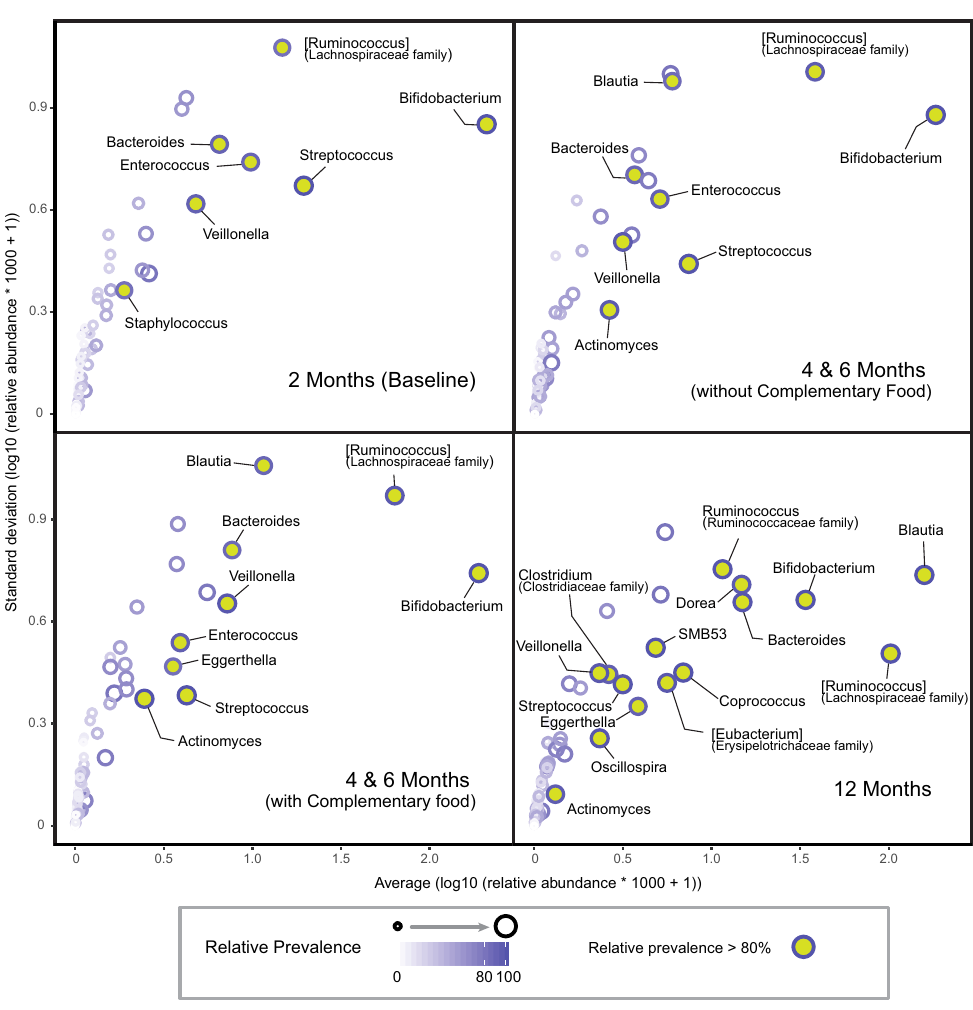
higher percentage of Akkermansia in the stool, and this was more prevalent when no or low complementary food was introduced (SI Fig. 3a). At 12 months, the number of individuals with Haemophilus was lower in infants who consumed EF compared with those who consumed SF (SI Fig. 3b, ANCOM test followed by FDR correction). In comparison to BF infants, FF infants showed a slightly higher microbial richness (observed species) at 2 months (p = 0.077, Kruskal Wallis H test), but not statistically different (or close to statistically different) at other time points examined. When applying “Tail” statistics index (a more robust estimate of microbial diversity to account for low-abundance rare species 34 ), no significant difference was detected between the two FF groups or between BF and FF infants, which may be due to the fact that some of the FF-infants were likely breast-fed after delivery for some time before enrolment at ~2 months of age. fecal metabolome. To evaluate the impact of early diet on intestinal microbial fermentation capability, corre- sponding fecal metabolites were examined. In agreement with prior studies 35 , BF infants in this cohort also had higher stool frequency and softer/looser stool consistency compared to FF infants 25 . In this subgroup, we observed signifi- cantly higher fecal water % and Bristol score in BF infants compared to the FF infants when infants were exclusively breast-fed or formula-fed respectively. However, after introduction of complementary food the water content in the stool of BF infants decreased to a level similar to both formula groups (Fig. 3a). Comparison of the water content in the stool of the formula groups revealed that infants consuming EF had less water in their stool than infants consuming SF (Fig. 3a). Since fecal water % was significantly different between groups, instead of normalizing fecal metabolite con- centration by wet or dry fecal weight, values were expressed in µ M. Fecal metabolite concentrations were associated with the amount of water in the stool. With increased water, higher concentrations of sugar monomers (glucose, galactose) and fermentation byproducts from carbohydrate metabolism (lactate, 1,2-propanediol, and succinate) were observed. In contrast, the concentration of micro- bial by-products from amino acid degradation (isobutyrate, isovalerate, dimethylamine, and phenylacetate) were associated with lower fecal water % (Fig. 3b–h).